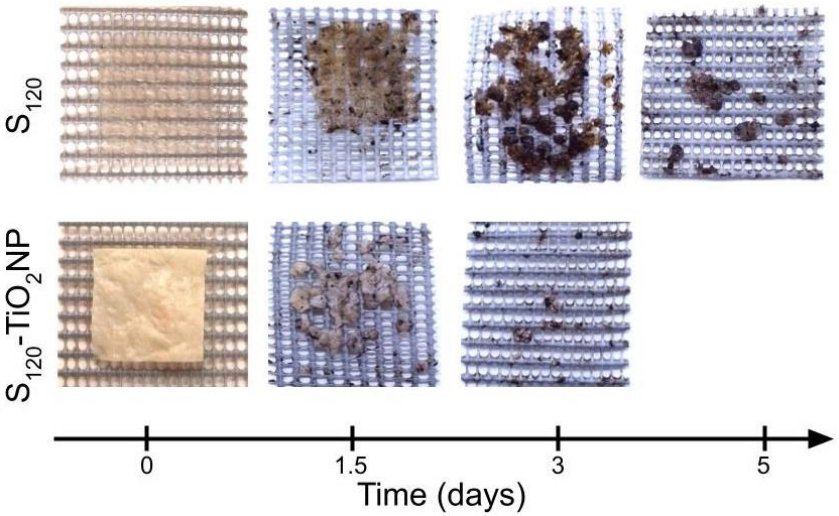
Figure 9. Photographs of the tested materials at different timings of the degradation process.